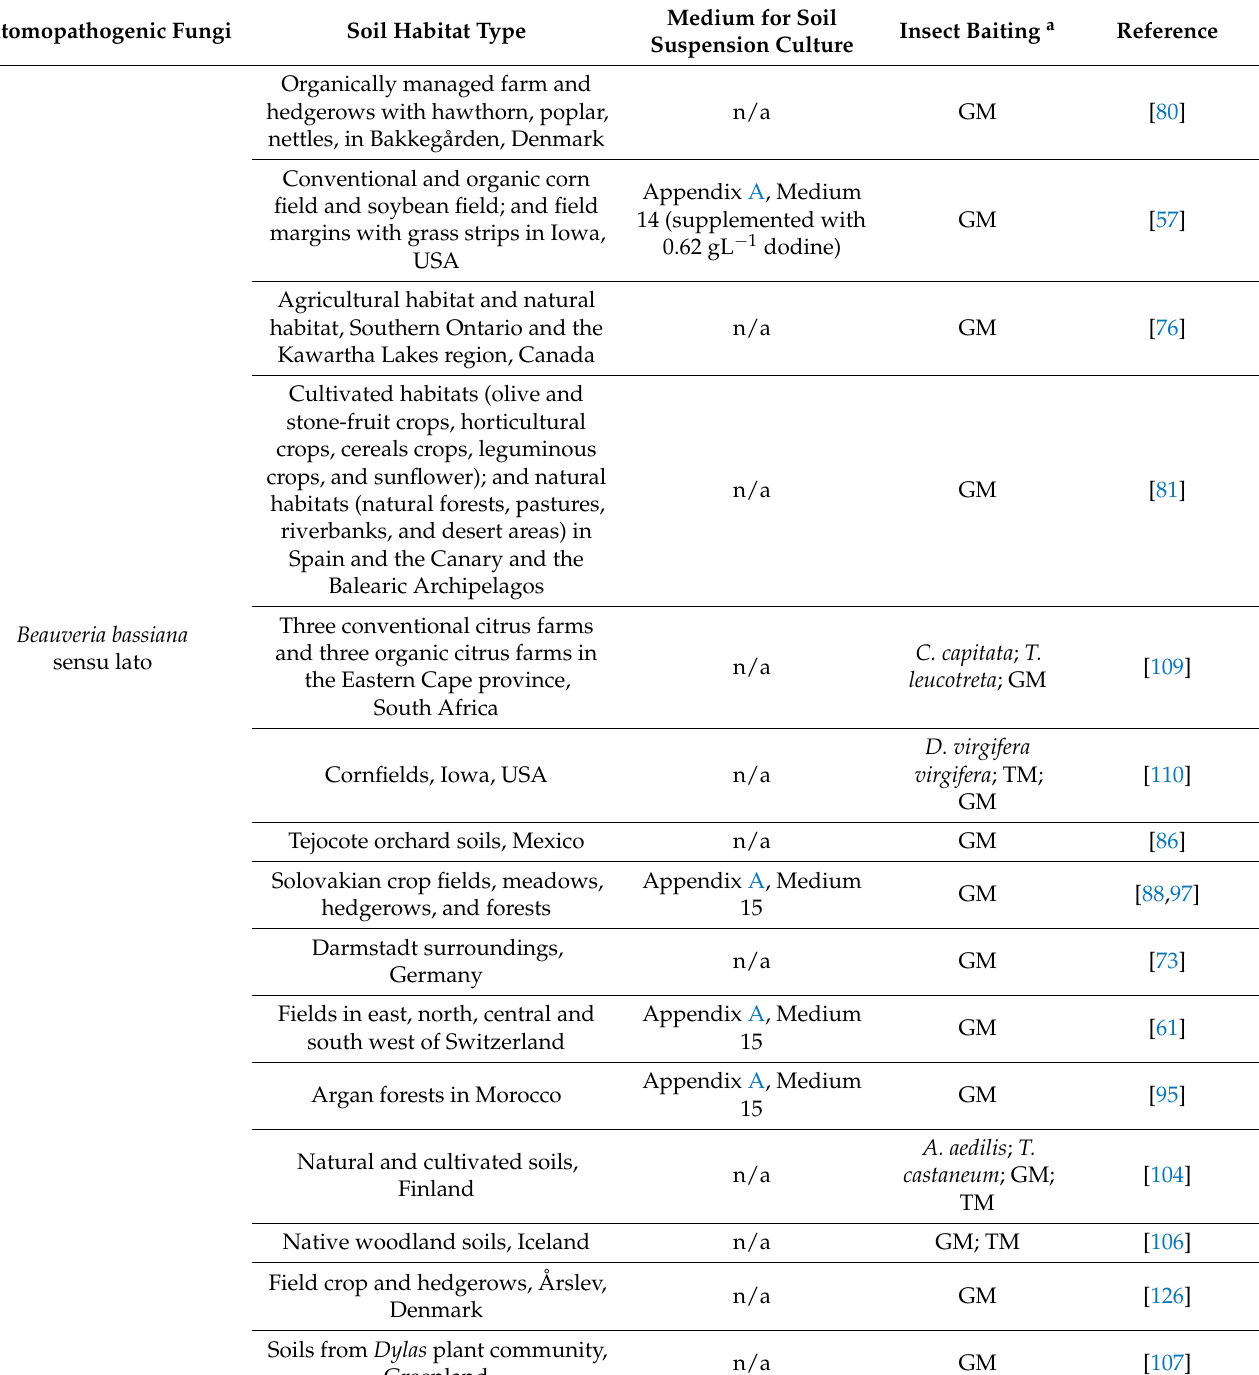
Table 3. Studies on the isolation of common entomopathogenic fungi from different soil types through insect baiting or soil suspension culture on selective